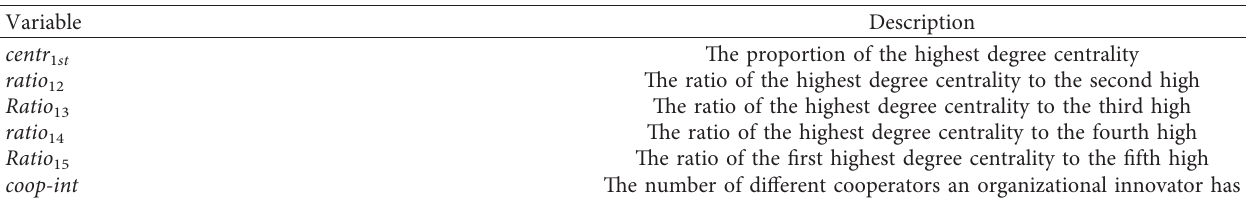
Table 3: Clustering variables and